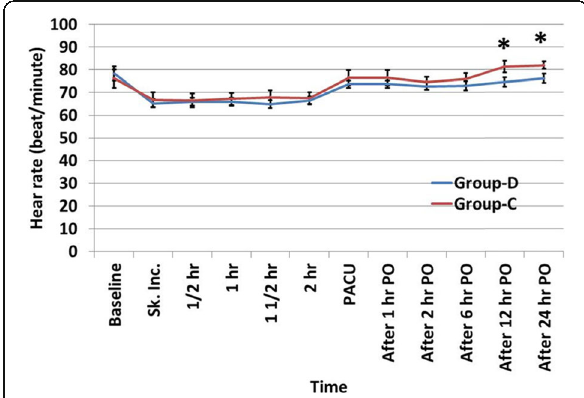
Fig. 1 Comparison between the C group and D group according to heart rate (beats/min)